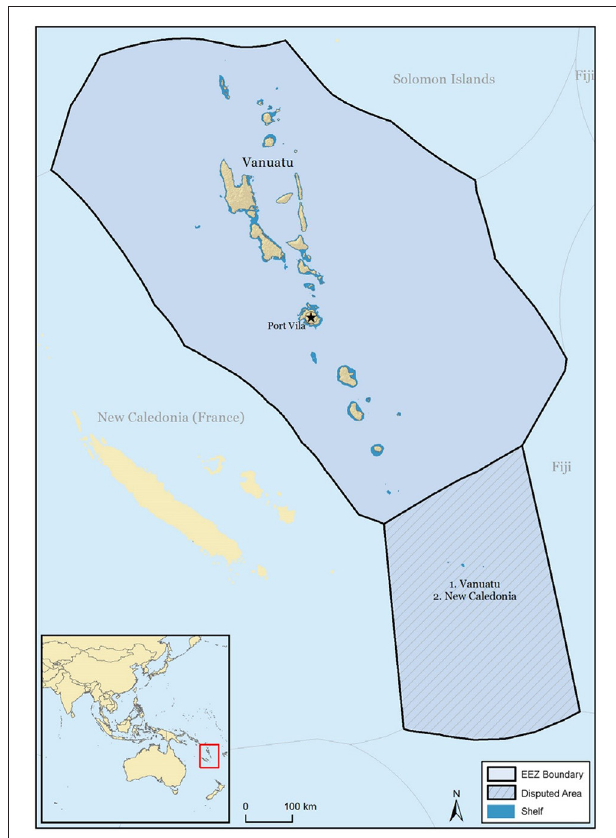
FIGURE 1 | Exclusive Economic Zone (EEZ) and shelf waters to 200m depth of Vanuatu. Source: Sea Around Us